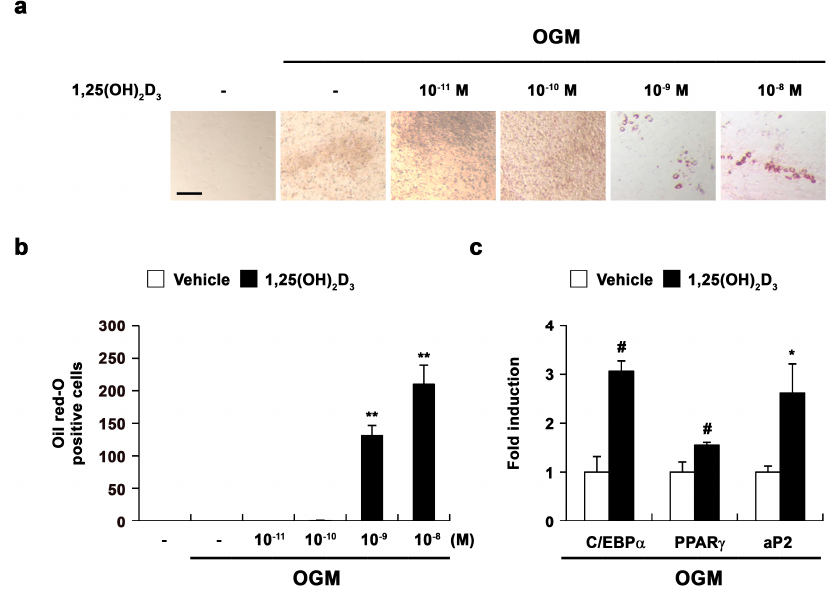
Figure 2. 1,25(OH) 2 D 3 induces transdifferentiation of osteoblasts to adipocytes. ( a – c ) Primary osteoblasts were cultured in osteogenic medium (OGM) with vehicle or increasing concentrations of 1,25(OH) 2 D 3 . ( a ) Cultured cells were fixed and stained with Oil Red-O, Bar: 50 µm; ( b ) The number of Oil Red-O—positive cells was counted; ( c ) Primary osteoblasts were cultured in osteogenic medium (OGM) containing either vehicle or 1,25(OH) 2 D 3 (10 − 8 M). The mRNA levels of CCAAT/enhancer binding protein- α ( CEBP- α ), peroxisome proliferator-activated receptor- γ ( PPAR- γ ), and adipocyte protein 2 ( aP ) were analyzed by real-time PCR. # p < 0.05; * p < 0.01; ** p < 0.001 as compared with controls.